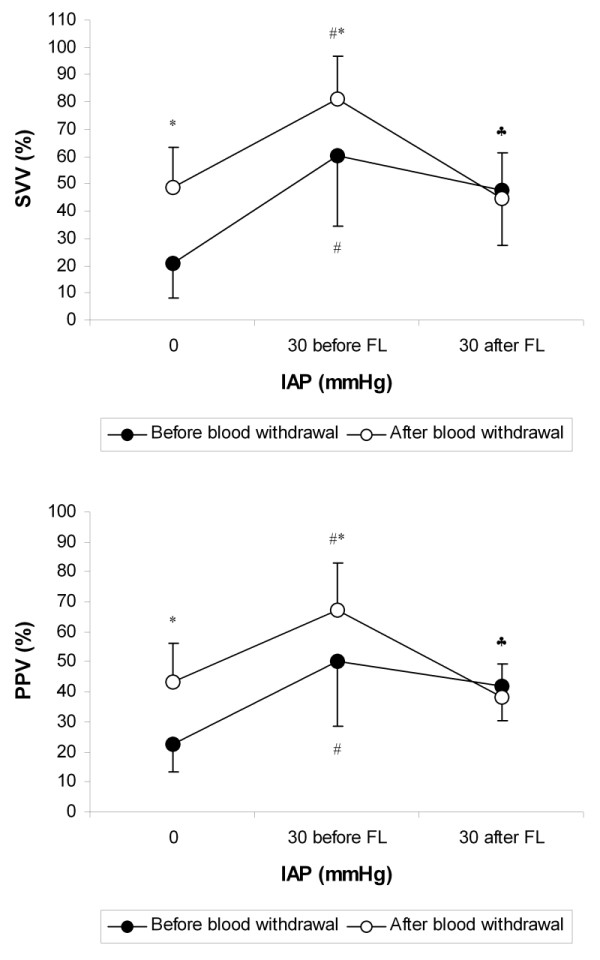
Effects of alterations in IAP and volemia on SVV and PPV. Definition of abbreviations: FL, fluid loading; IAP, intra-abdominal pressure; PPV, pulse pressure variation; SVV, stroke volume variation. # : P < 0.05 vs IAP 0; * : P < 0.05 vs before blood withdrawal; ♣ : P < 0.05 vs IAP 30 before FL for the animals after blood withdrawal. Before blood withdrawal, n = 9 at IAP 0, 30 before FL and 30 after FL; after blood withdrawal, n = 9 at IAP 0, n = 7 at IAP 30 before FL and 30 after FL.